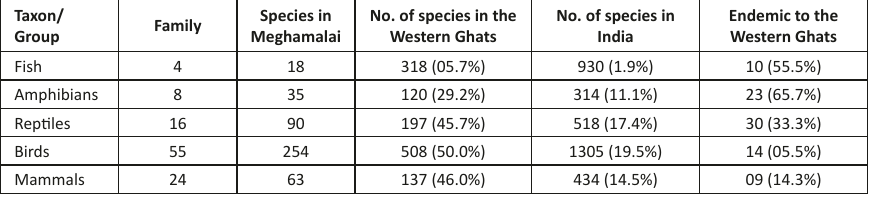
Table 1. Richness of selected taxa in Meghamalai, Western Ghats; percent in